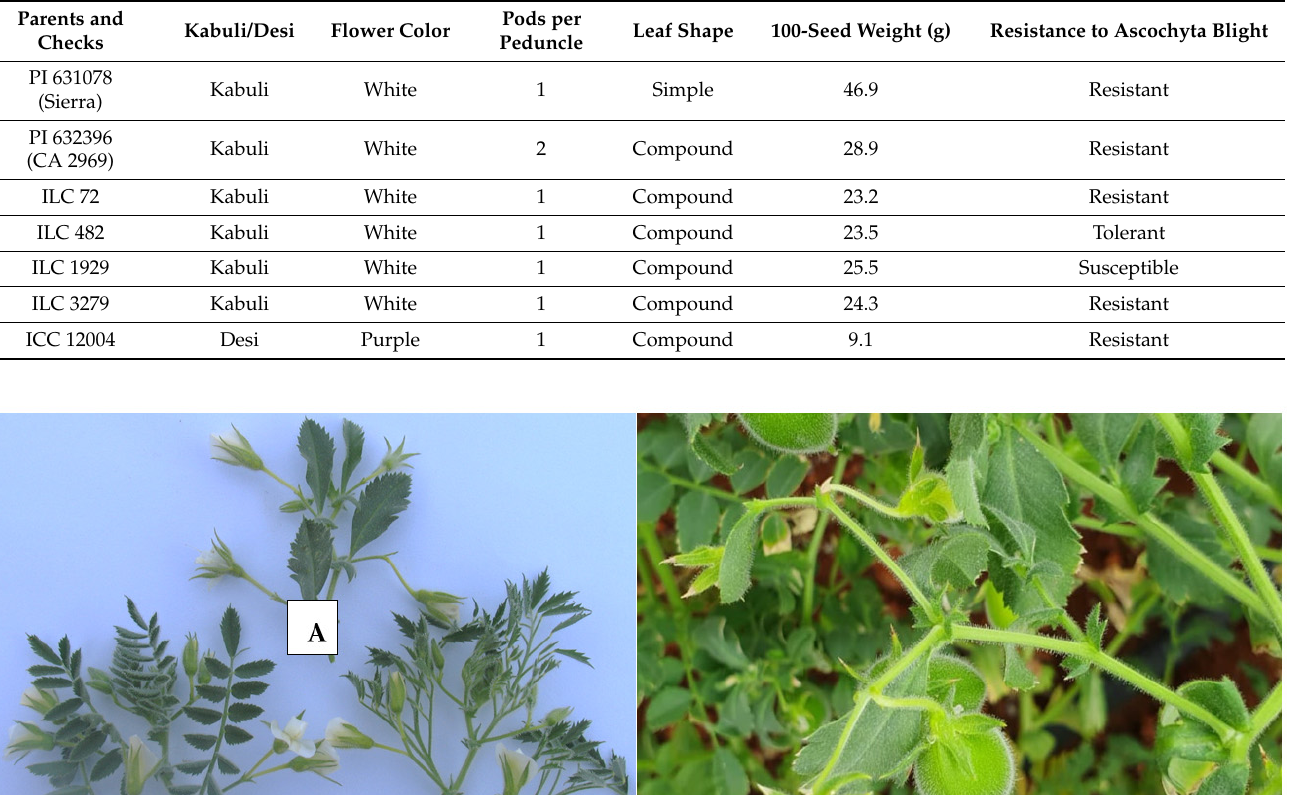
Table 1. Agro-morphological traits and reaction to ascochyta blight of checks and parents.